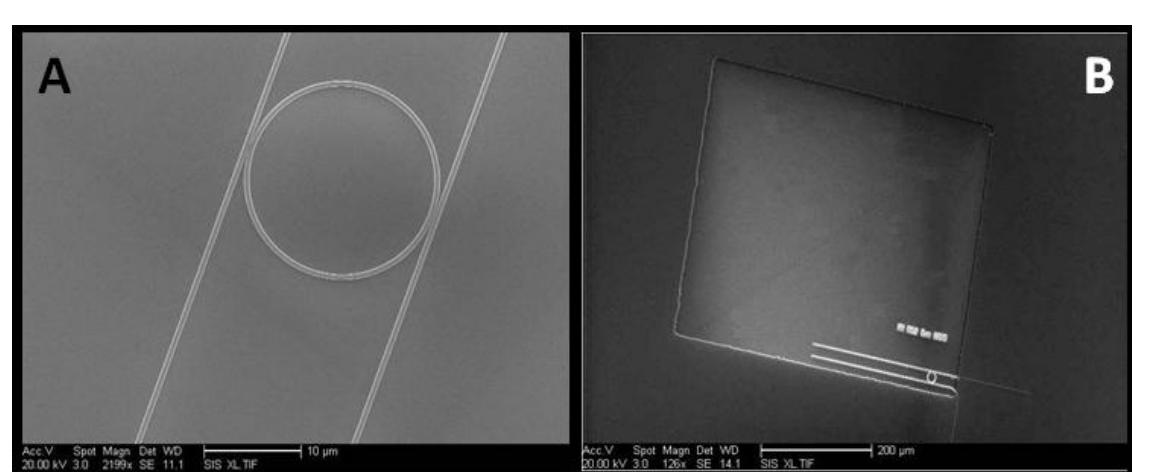
Figure 7. Fabricated ring resonator samples. ( A ) Close up of the ring resonator structure; ( B ) Ring resonator with a window etched in SiO